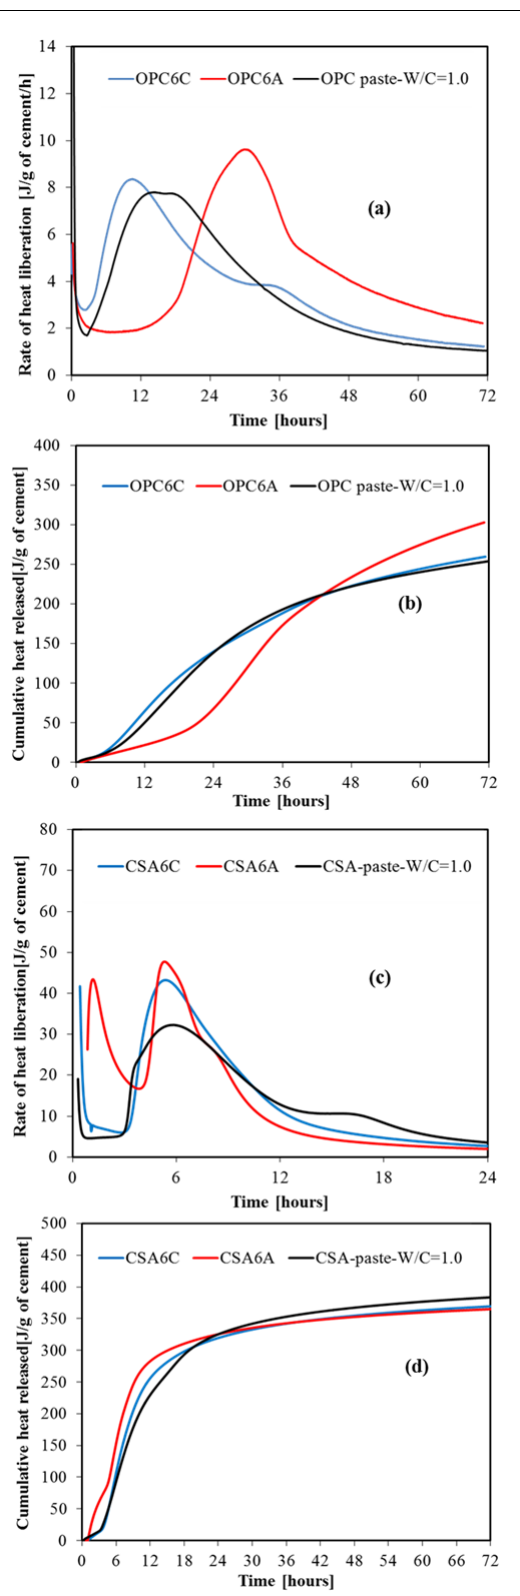
Figure 4. Calorimetry test results of CBEA mixtures: cationic emulsion with 6% cement (blue), anionic emulsion with and 6% cement (red) and cement paste with w/c 1.0 (black) (modified from [46], Fig. 4a and 4b show test results of OPC; Fig. 4c and 4d show test results of CSA cement). The evolution of the cumulative heat mirrors the evolution of the degree of hydration of the cement.